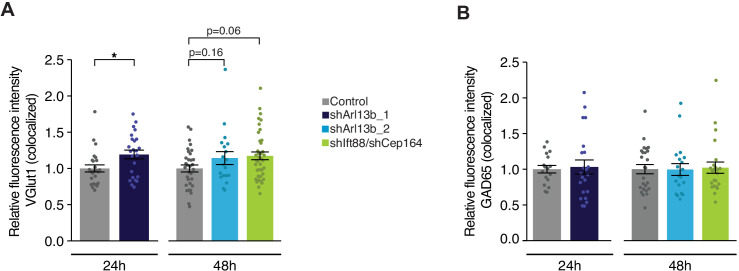
Presynaptic VGlut1 staining is increased upon acute knockdown of ciliary proteins.(A and B) Relative fluorescence intensity of immunolabeled VGlut1 (A) or GAD65 (B) at GluA2/VGlut1 or Gephyrin/GAD65 colocalized puncta, respectively, in neurons transfected with the indicated plasmids at 24 hr or 48 hr post transfection. Intensity values are normalized to values in controls. Each dot is the average summed pixel value of examined synapses per neuron. Bars are average ± SEM. * indicates p<0.05 for the indicated conditions; additional p-values are also indicated. (A) n: (24 hr) Control = 25, shArl13b_1 = 24; (48 hr) Control = 32, shArl13b_2 = 19, shIft88/shCep164 = 39; four dissociations. (B) n: (24 hr) Control = 17, shArl13b_1 = 22 neurons; four dissociations; (48 hr) Control = 25, shArl13b_2 = 19, shIft88/shCep164 = 23; three dissociations.
Figure 2—figure supplement 1—source data 1.Source data for Figure 2—figure supplement 1.